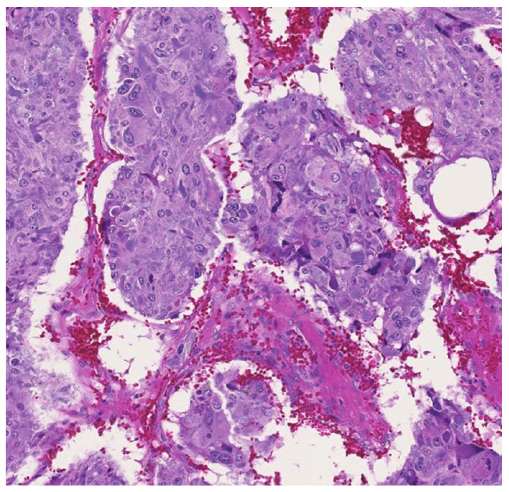
Figure 1: There is a heterogeneous mass measuring 6.0 × 5.0 × 4.9 cm in the expected location of right adrenal gland (arrow). Figure 2: Pheochromocytoma: nests and sheets of amphophilic polygonal cells are separated by vascular